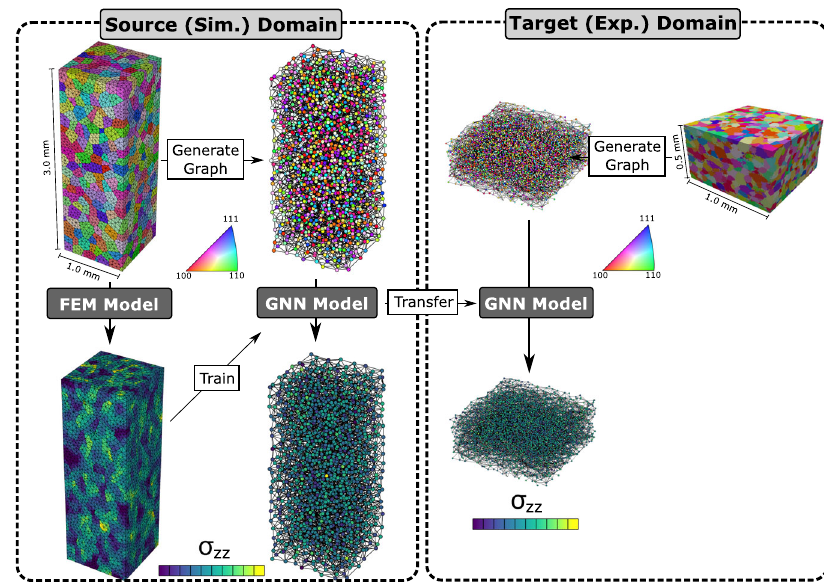
Fig. 9 Overview of transfer learning approach for GNN surrogate model evaluation. Connectivity of the various efforts used to evaluate the accuracy of GNN surrogate models for predicting the stress response in individual grains during elastic